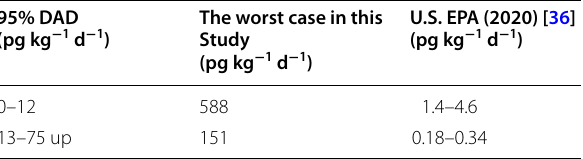
Table 3 Dermal absorbed dose of HBCDs based on the worst case by age groups